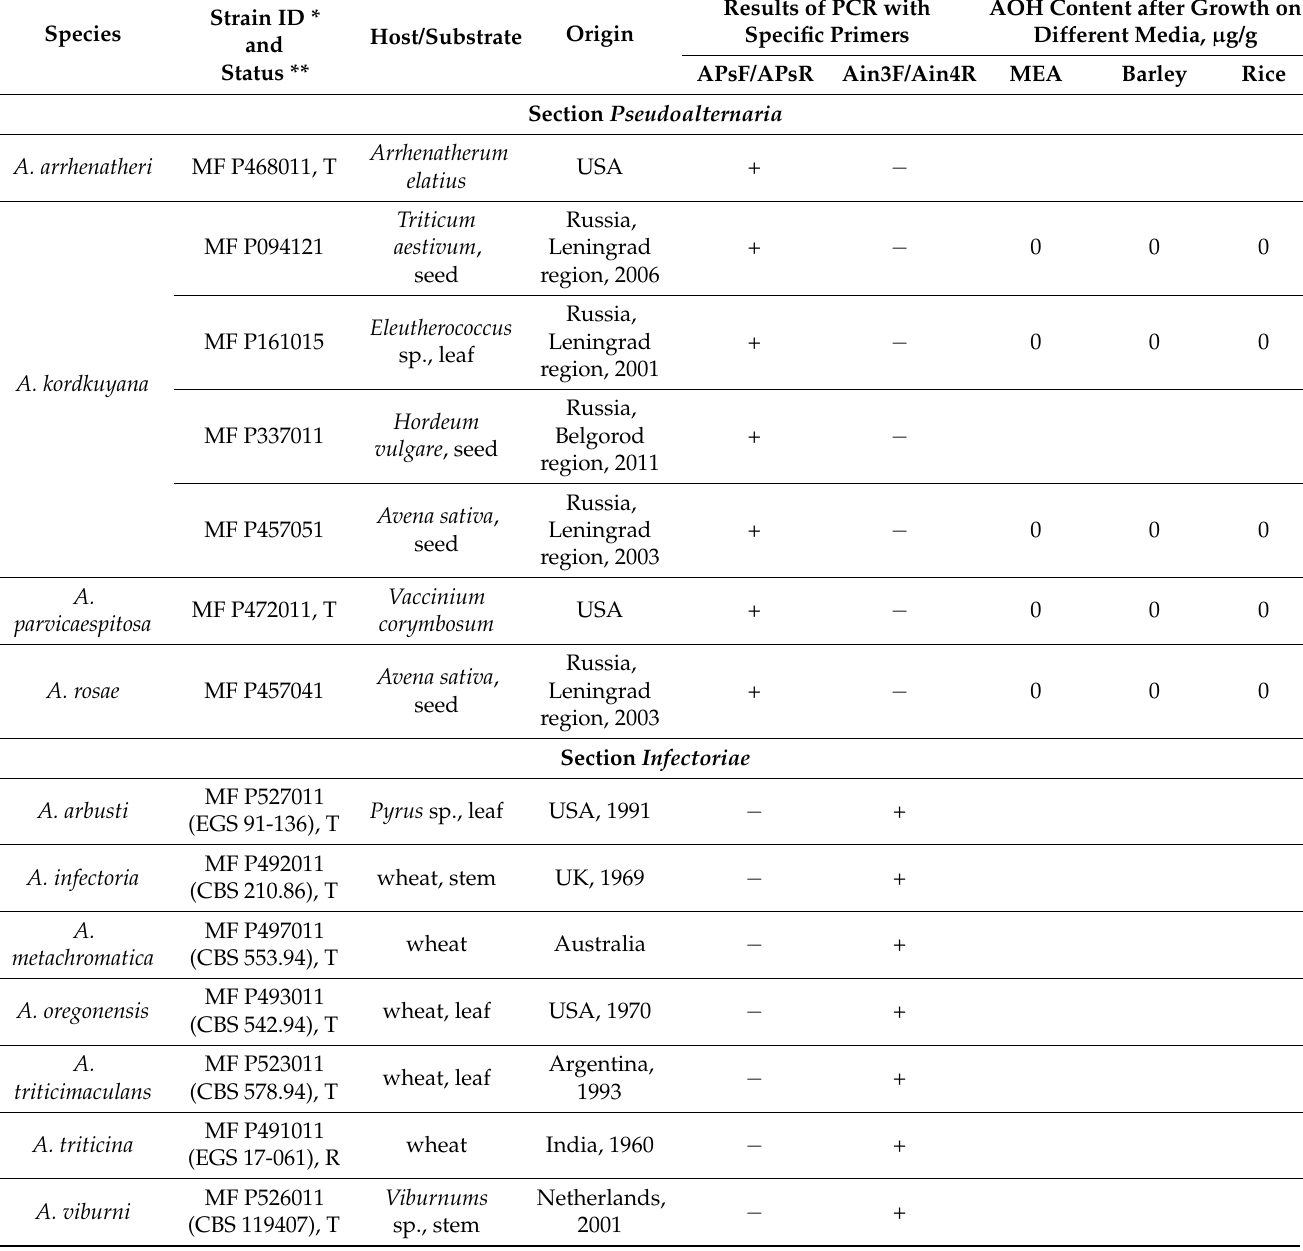
Table 1. Alternaria spp. strains used for the study and results of specific PCR and their alternariol (AOH) producing